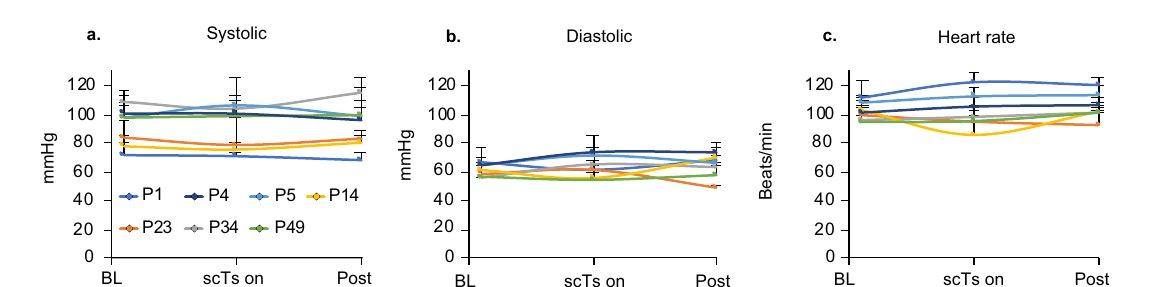
Table 3 Incidence of risks associated with transcutaneous spinal cord stimulation. Risks # of instances (% occurrences) Likelihood of event based on probability Lower extremity motor responses Likely to occur Skin redness under stimulating electrodes May occur half of the time Pain from stimulation Unlikely to occur Autonomic dysre fl exia Very unlikely to occur Numbness Very unlikely to occur % occurrence = # of instances/ # of assessments. Total of 22 assessments in 8